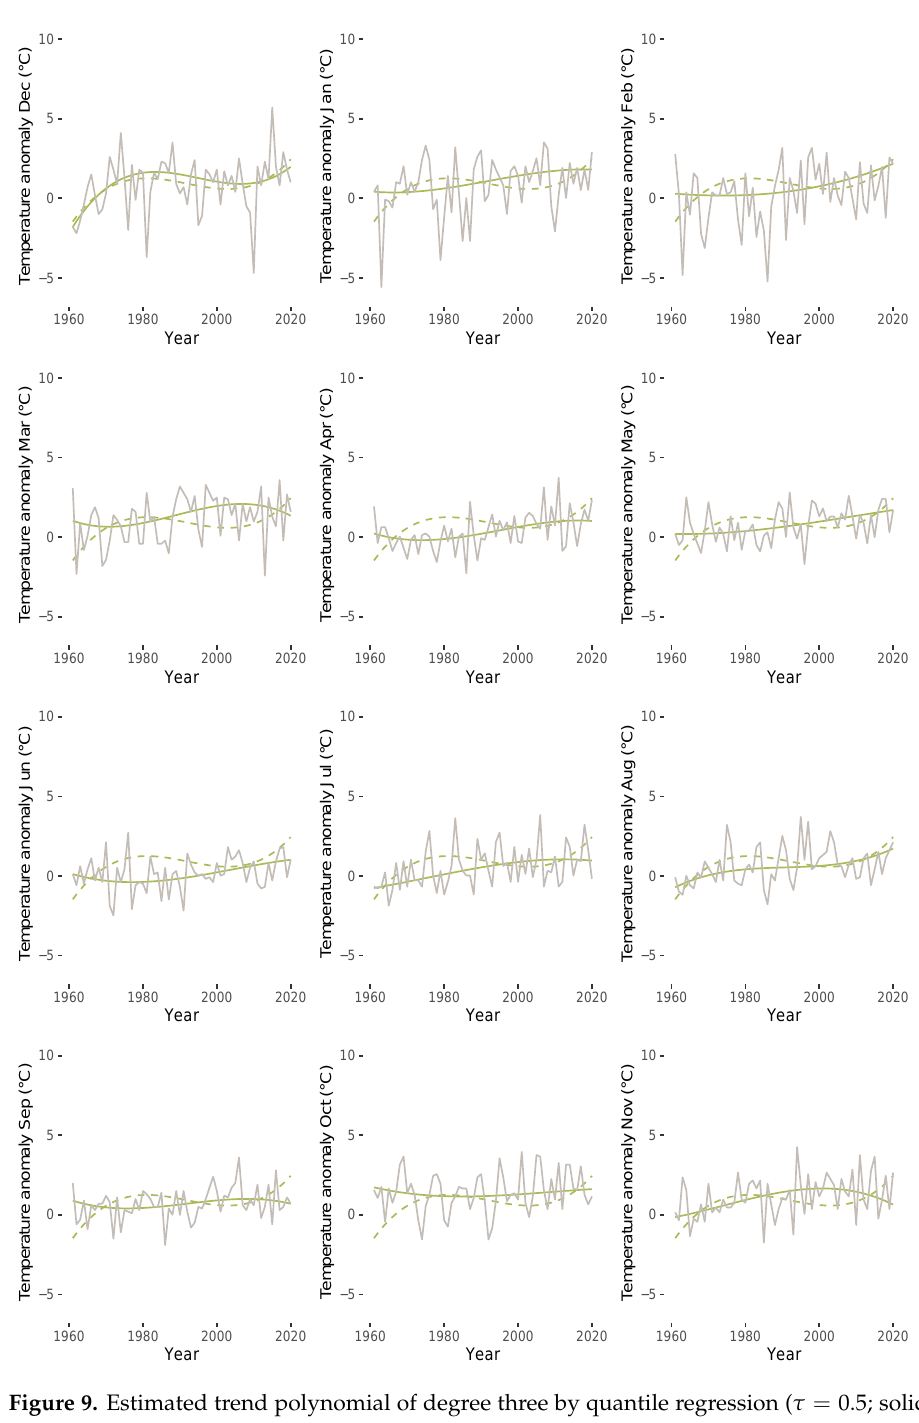
starting from December (top left) to November (bottom right). The trend regressions were fitted by employing a polynomial of degree three in a quantile regression with τ = 0.5 (solid green line) and a least squares regression (dashed green line). The figure highlights median for all months except December. In particular, skewness and extreme values lead to a much more wiggly behavior of the mean trend compared to the median trend.